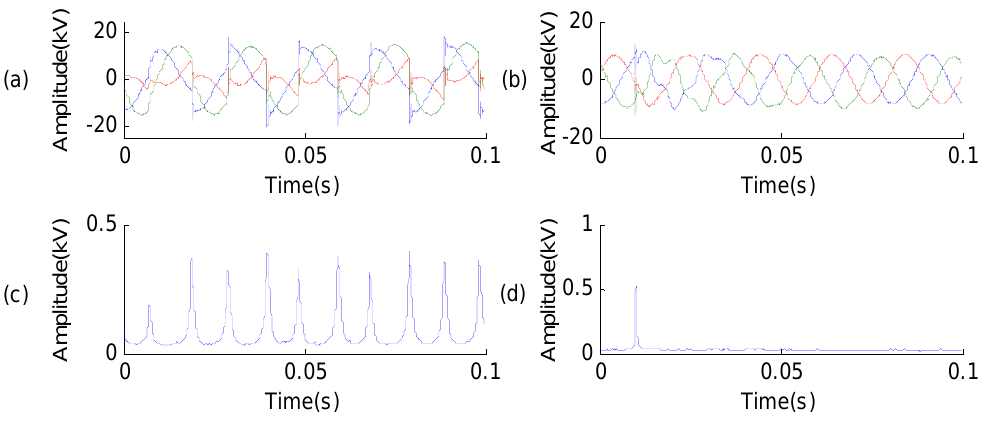
Figure 7. ( a ) Arc grounding; ( b ) Capacitor switching; ( c ) Mean amplitude curve of arc grounding; ( d ) Mean amplitude curve of capacitor switching.